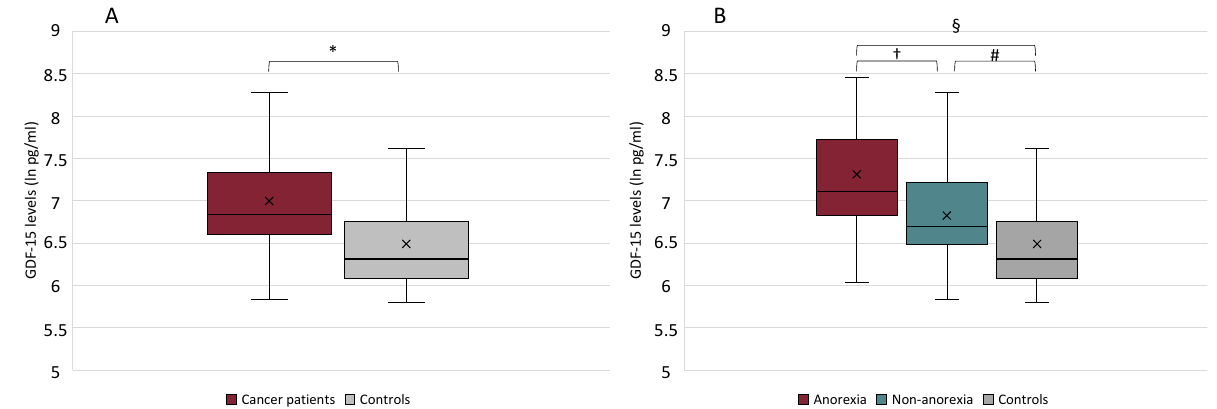
Figure 1. Growth Differentiation Factor 15 (GDF-15) serum levels in cancer patients vs. controls (* p = 0.00016) ( A ) and in cancer patients with anorexia, without anorexia, and in controls (Kruskal–Wallis test between the three groups p = 0.00004) ( B ). † p = 0.005; § p < 0.0001; # p = 0.006. Based on the presence/absence of anorexia, the GDF-15 serum levels were significantly higher in anorexic (median 7.11, IQR 6.86;7.49) vs. non-anorexic cancer patients (median 6.70 IQR 6.50; 7.16) ( p = 0.005) and vs. controls (median 6.31 IQR 6.09; 6.73) ( p < 0.0001), as well as higher in non-anorexic cancer patients vs. controls ( p = 0.006) (Figure 1B). Gastrointestinal cancer patients showed higher GDF-15 serum levels (median of 7.46 IQR, 6.80; 7.77) with respect to lung cancer patients (median 6.72 IQR 6.54; 6.95) ( p = 0.0004). Both cancer groups showed GDF-15 serum levels higher compared to controls ( p = 0.00006; p = 0.008, respectively) (Figure 2).